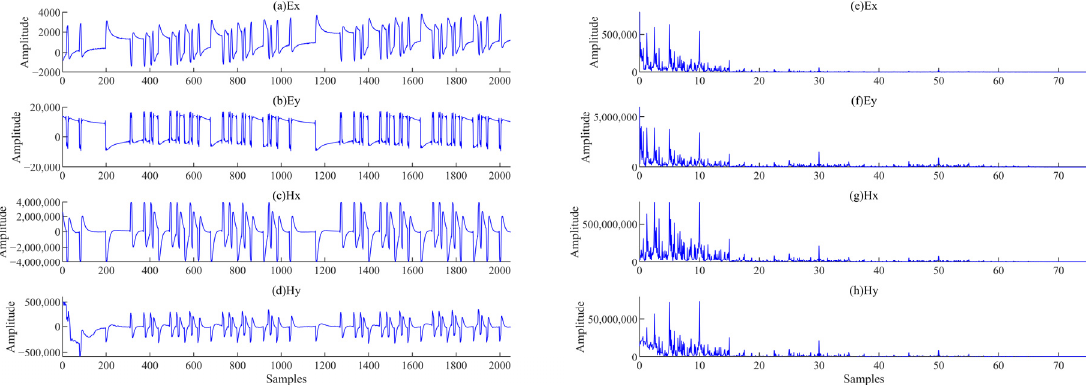
Figure 13. The MT data. Time domain waveform of ( a ) Ex component; ( b ) Ey component; ( c ) Hx component; ( d ) Hy component. The left panels are time domain waveforms, and the right panels are their spectra. Spectrum of ( e ) Ex component; ( f ) Ey component; ( g ) Hx component; ( h ) Hy component.